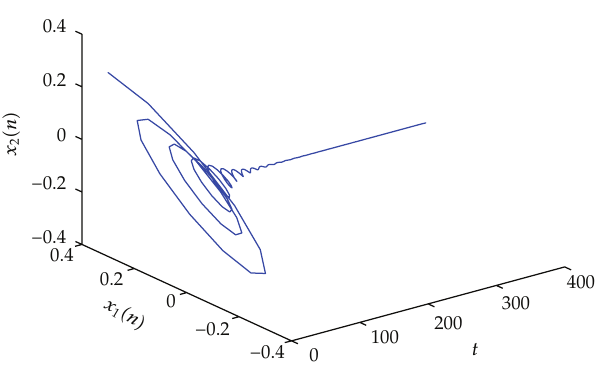
Figure 4: The equilibrium (cid:2) 0 , 0 (cid:3) is asymptotically stable. The initial value and parameter D are (cid:2) 2 , 3 (cid:3) and 38 / 15, respectively.